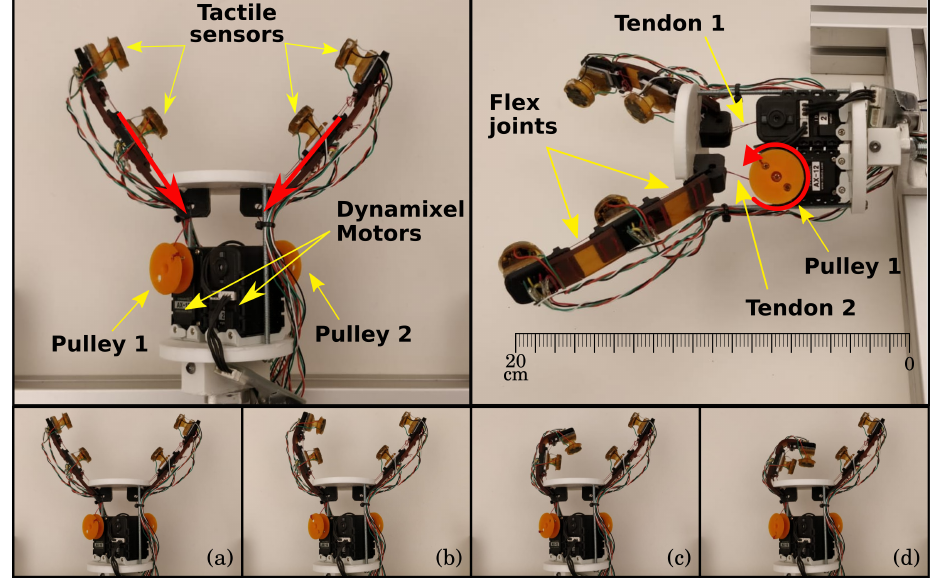
Figure 2. Top and side view of the modified gripper design. ( a ) rest position; ( b ) initial movement; ( c ) inger actuation; ( d ) maximum safe